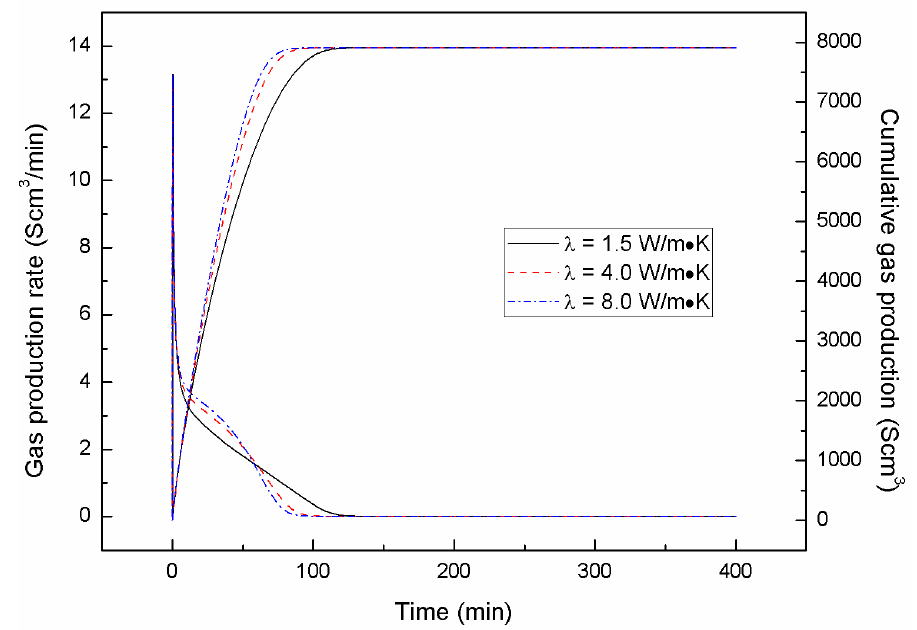
Figure 5. Gas production rate and cumulative gas production time evolution for different thermal conductivity of the hydrate-bearing porous media with the same depressurizing